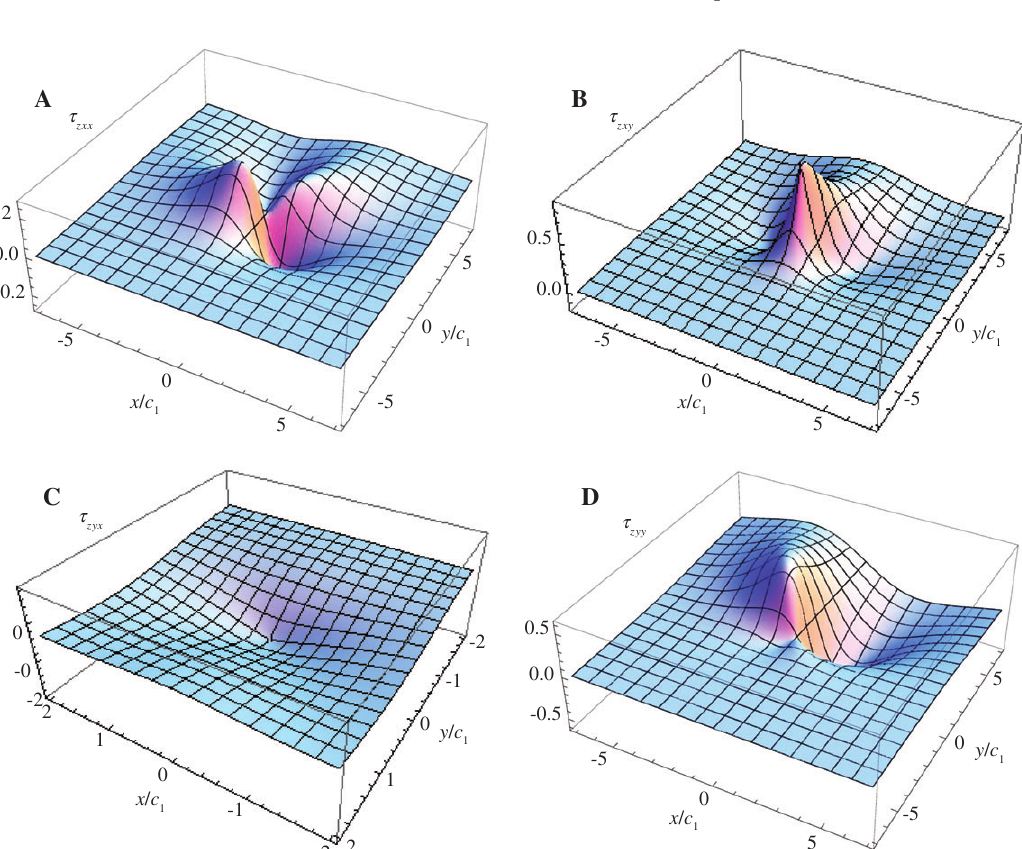
= 0.5. Double / c 2 1